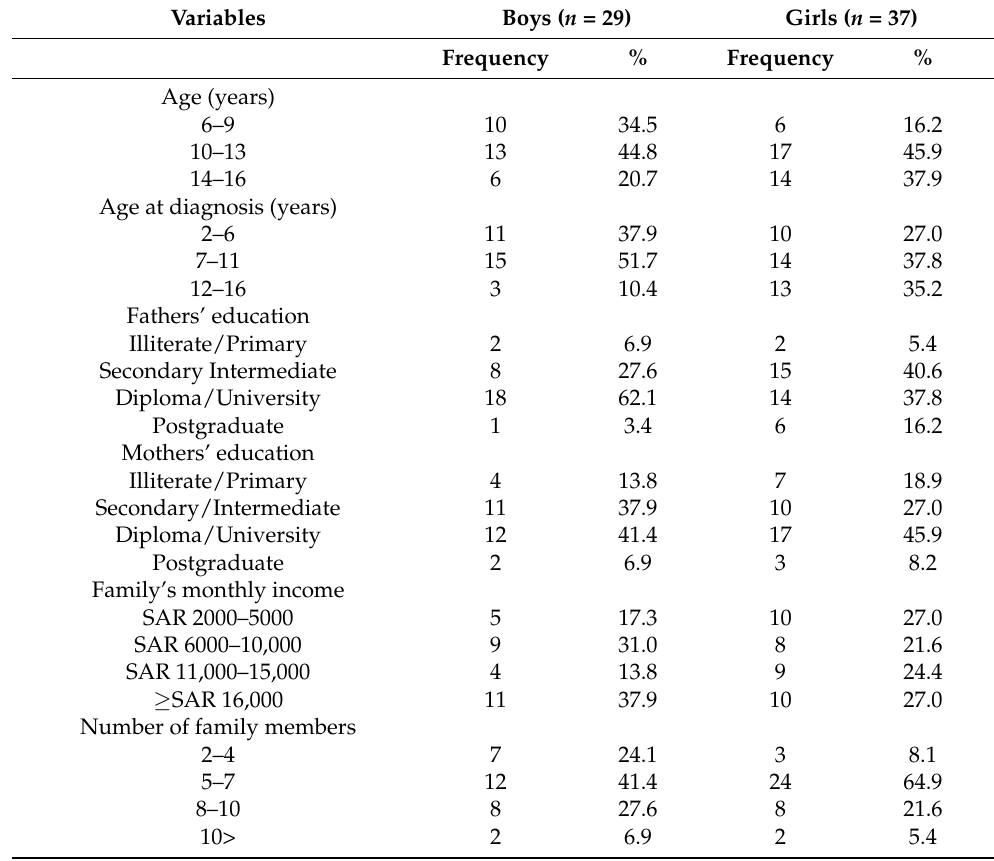
Table 1. Distribution of the frequency of children ( n = 66) with CDs following the Ministry of Health GFD program, according to demographic